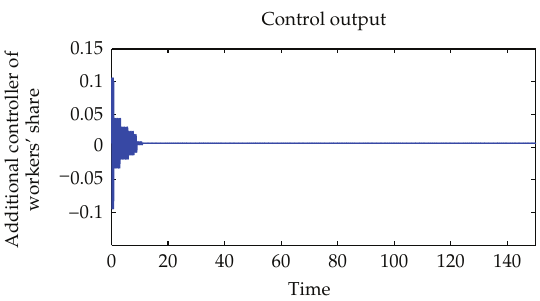
Figure 7: Additional controller of workers’ share of the MRC.